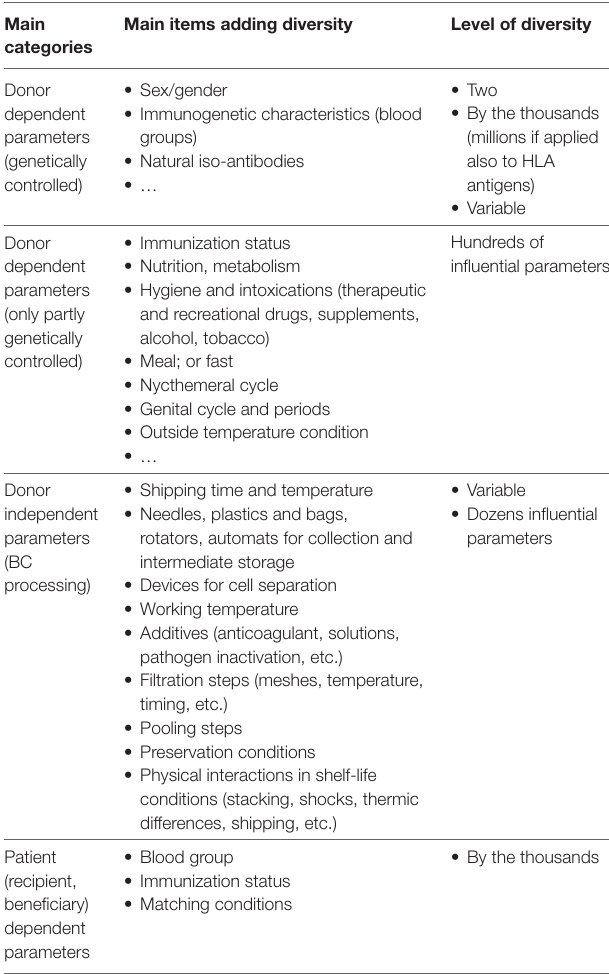
TABLe 1 | Parameters having proven or theoretical influence on the quality of the processed blood component